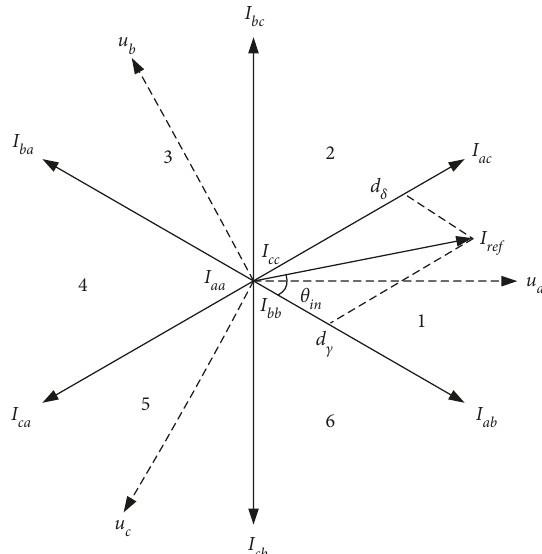
Figure 3: Space vector synthesis of rectification stage.